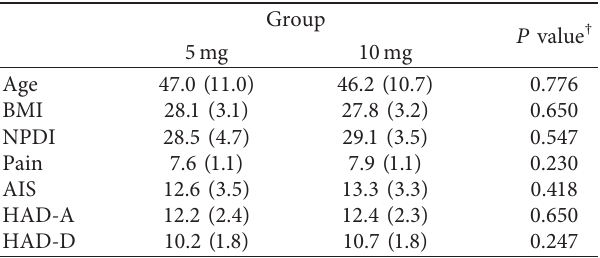
Table 2: Select baseline demographic and clinical characteristics of